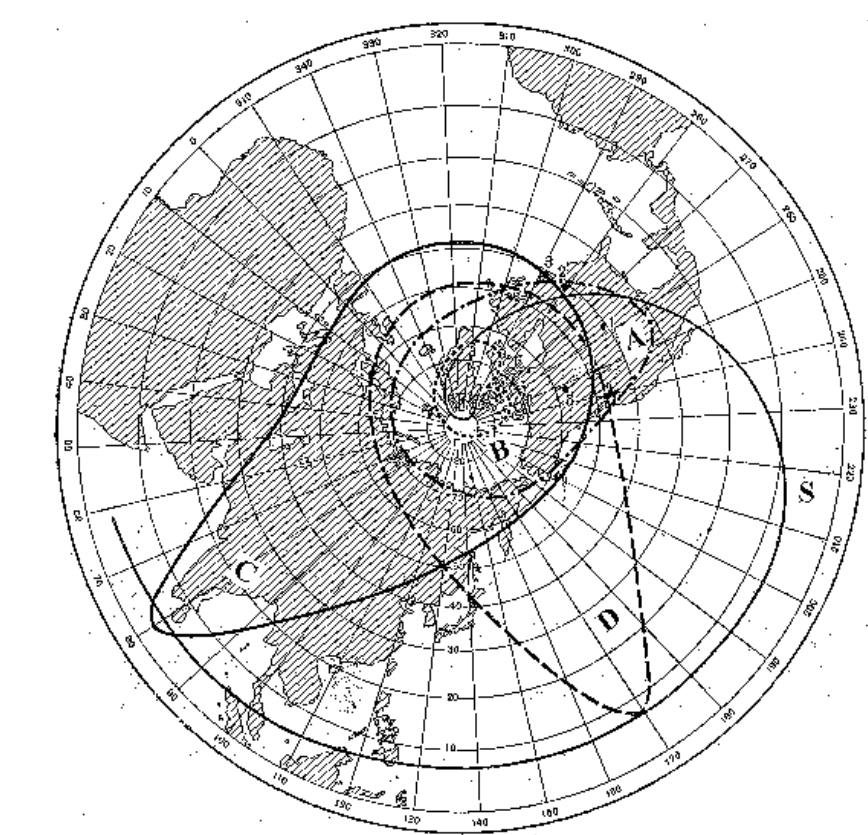
Figure 5. Location of solar corpuscular flux precipitation zones “A”, “B”, “C”, and “D” above Earth’s surface and corresponding maximum values of agitation and appearance frequency of auroras according to Nikolsky (1960a). Letter “S” marks Størmer’s spiral, which is arbitrarily prolonged towards low